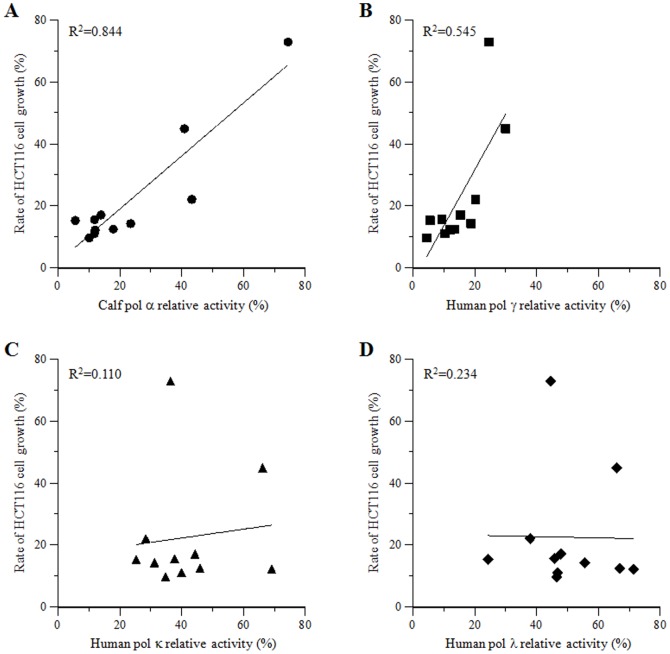
Relationship between mammalian pol inhibitory activities versus human cancer cell proliferation inhibition by plumbagin (1) and 5-O-acyl plumbagins (2a–j).X-axis indicates mammalian pol relative activity at 10 µM compound. (A) Calf pol α, (B) human pol γ, (C) human pol κ, and (D) human pol λ. Y-axis indicates rate of HCT116 human colon carcinoma cell proliferation at 100 µM compound. These data are based on Figs. 4 and 5; correlation coefficient values are shown in each panel.